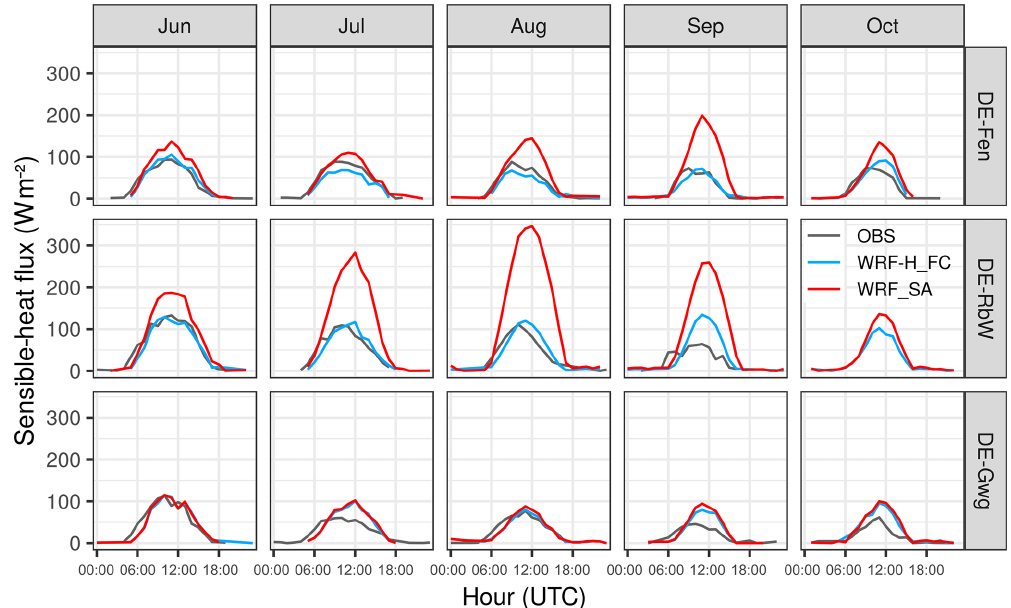
Figure 9. Mean diurnal cycles of simulated and observed sensible-heat flux for the months June to October 2016 at different TERENO Pre-Alpine Observatory